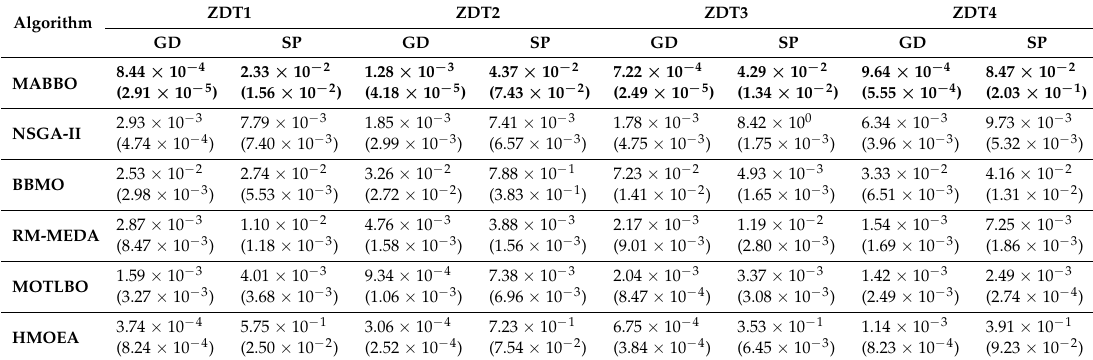
Table 2. Comparison on 2-objective test problems (ZDTs).